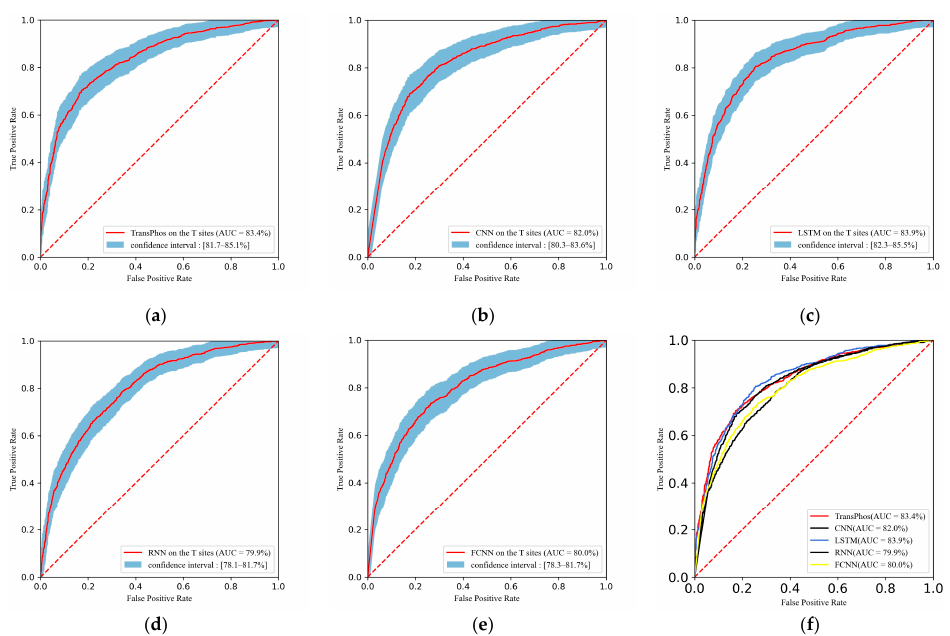
Figure A1. ROC curves containing 95% confidence intervals for different deep learning models on the T sites of the training dataset P.ELM, 10-fold cross validation was used. ( a ) ROC curve of the TransPhos model; ( b ) ROC curve of the CNN model. ( c ) ROC curve of the LSTM model. ( d ) ROC curve of the RNN model. ( e ) ROC curve of the FCNN model. ( f ) Performance comparison on the T sites of the P.ELM dataset.